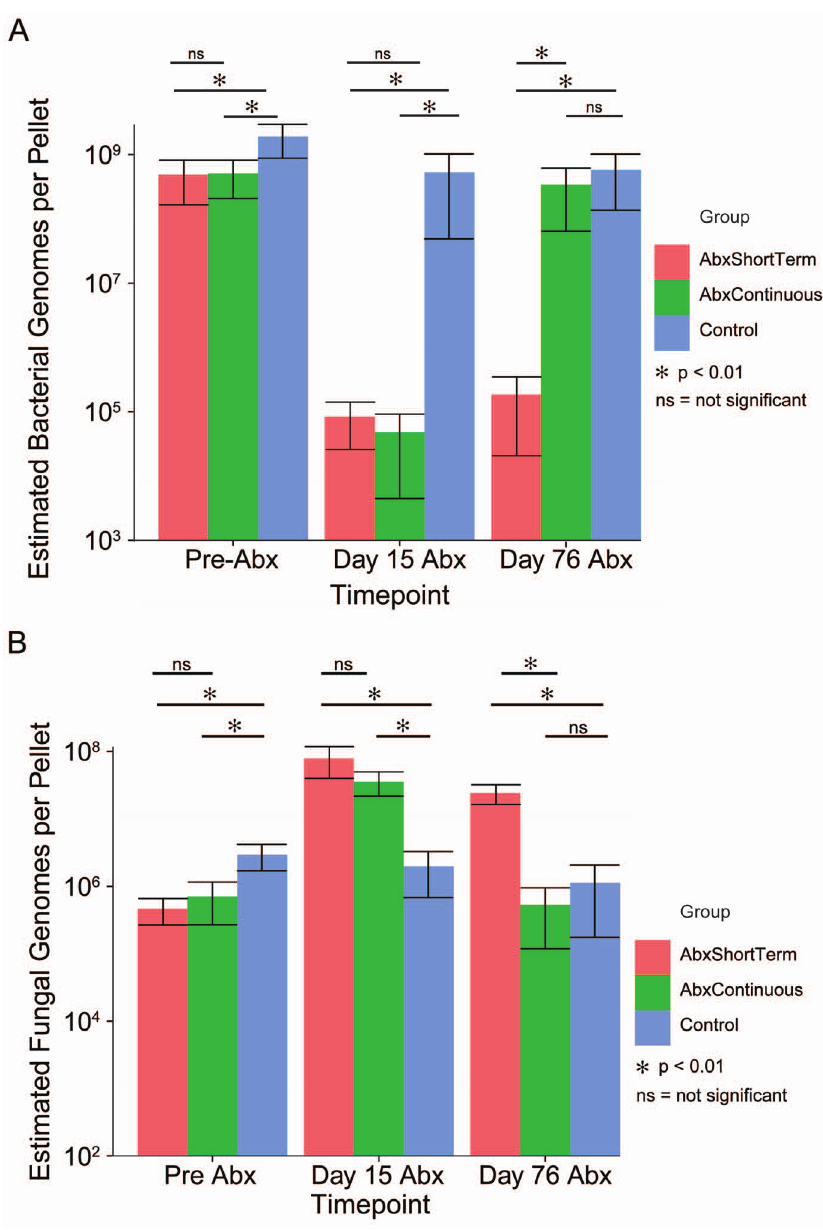
Figure 3. Numbers of organisms per stool pellet. Values from QPCR were corrected to yield an estimate of the true numbers of organisms by accounting for differential DNA yield, numbers of rRNA gene copies per genome, and efficiency of detection. A) Estimated numbers of bacterial genomes per pellet. Note that during antibiotic treatment (Day 15), most of the 16S rRNA gene copies were derived from food and do not correspond to intact organisms. (B) Estimated numbers of fungal genomes per pellet. The x-axis shows the time point studied, and the y-axis shows the inferred numbers of genomes. Each study group is indicated by the color code to the right of the figure panels.